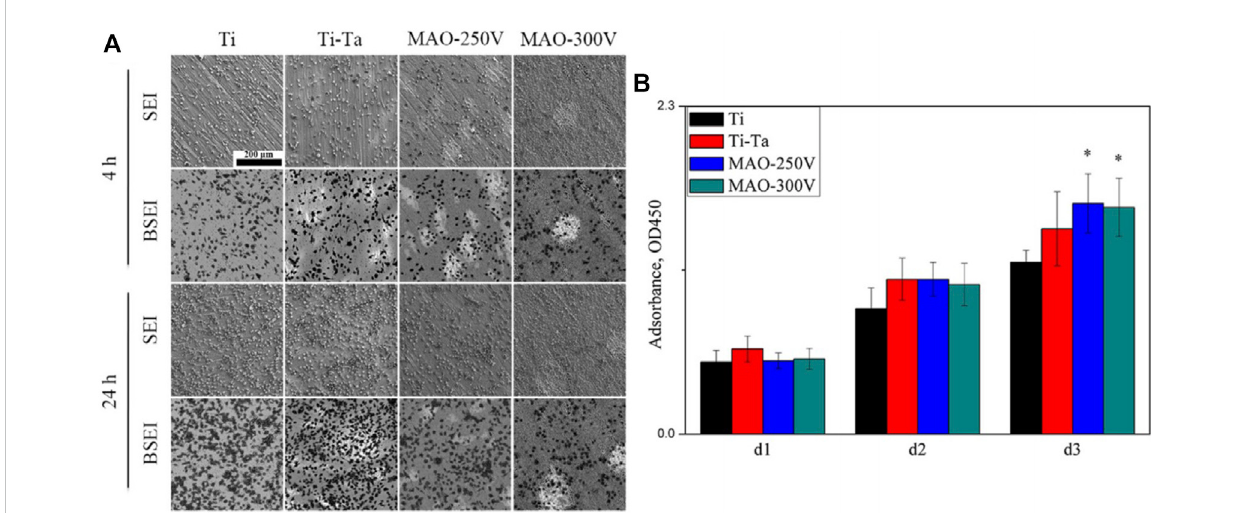
SEM images (A) and CCK-8 assay (B) showing the distribution and proliferation of SaOS-2 cells cultured on various surfaces. (Huang et al., 2018). Copyright ©2018 Published by Elsevier Ltd.